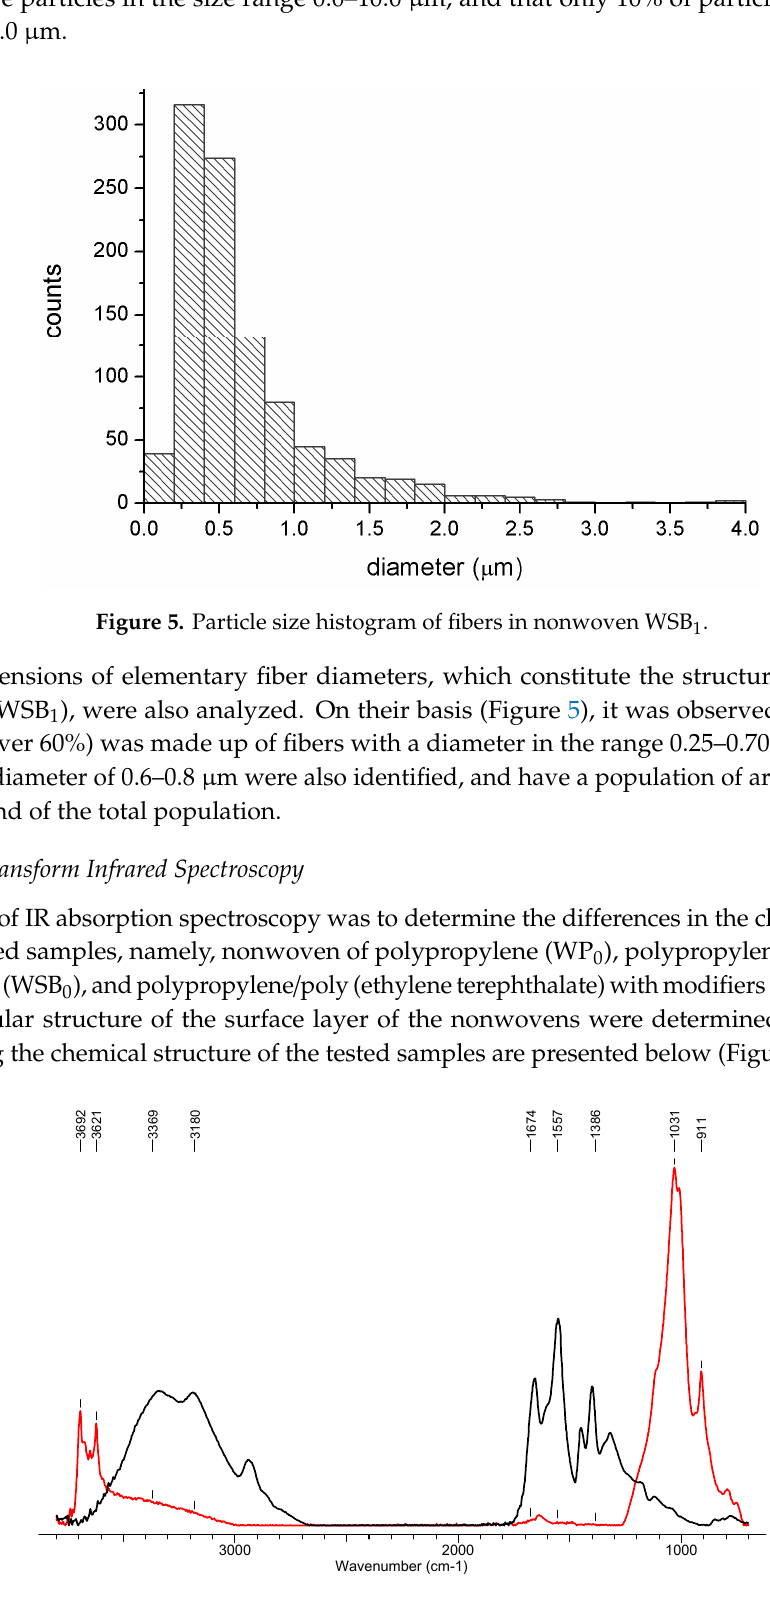
Figure 6. FTIR spectrum for modifiers: SAP (1—Black line) and Biohaloysite (2—Red line).